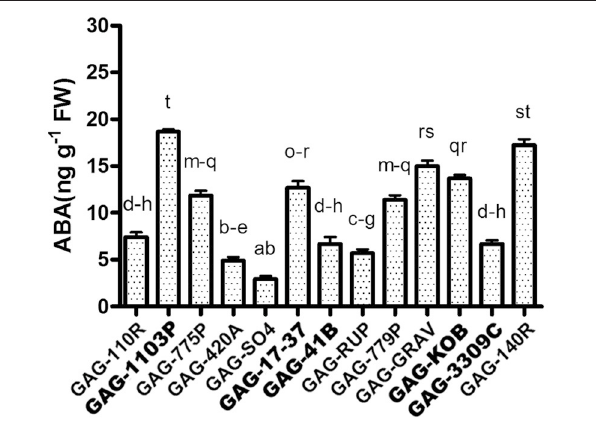
FIGURE 6 | Analysis of endogenous ABA levels. Measurement of the leaves active ABA content in the 13 graft combinations. Lower case letters above bars denote significant differences attested by Tukey’s HSD-test ( P < 0.05). Data are expressed as mean ± SE ( n = 3). The combinations chosen for RNA-seq analyses are indicated in bold